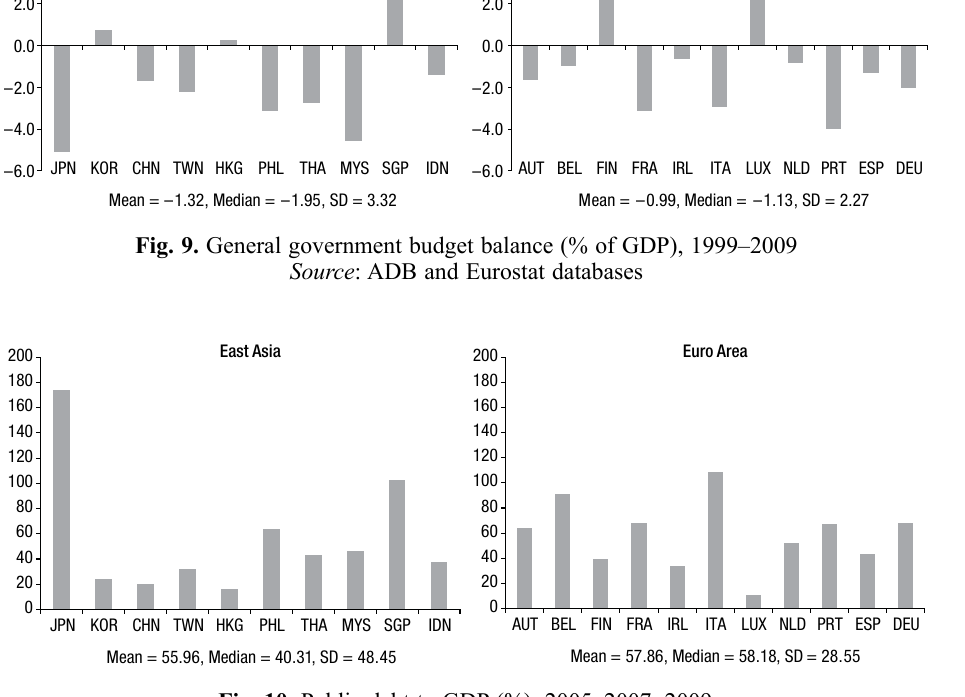
Fig. 10. Public debt to GDP (%), 2005–2007,